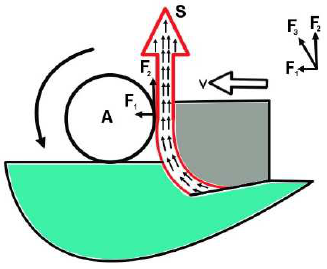
Figure 10. Schematic diagram of spherical chip movement. A is the rolling direction of spherical chips; S is the flow direction of chip atoms; and V is the direction of tool movement.